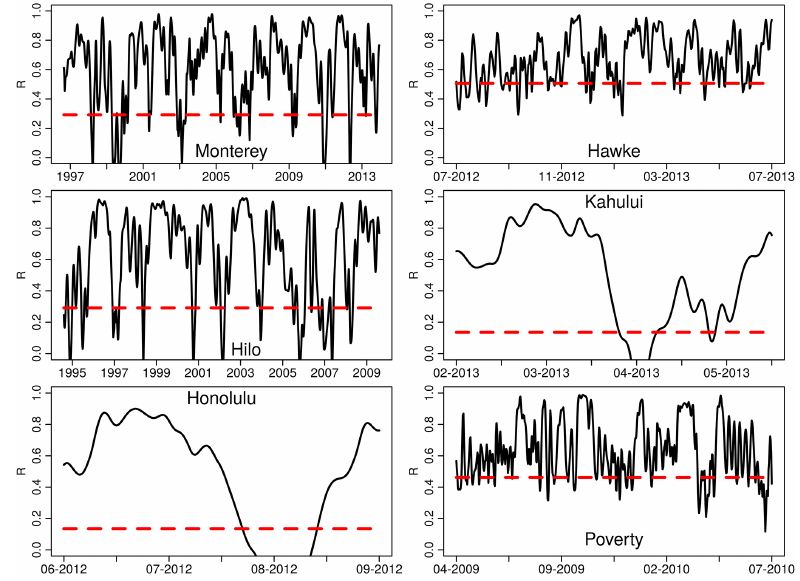
Figure 7. Correlation coefficients between tide and shelf-resonance metamode IMFs with fortnightly periods. The dashed red lines indicate the 95% confidence